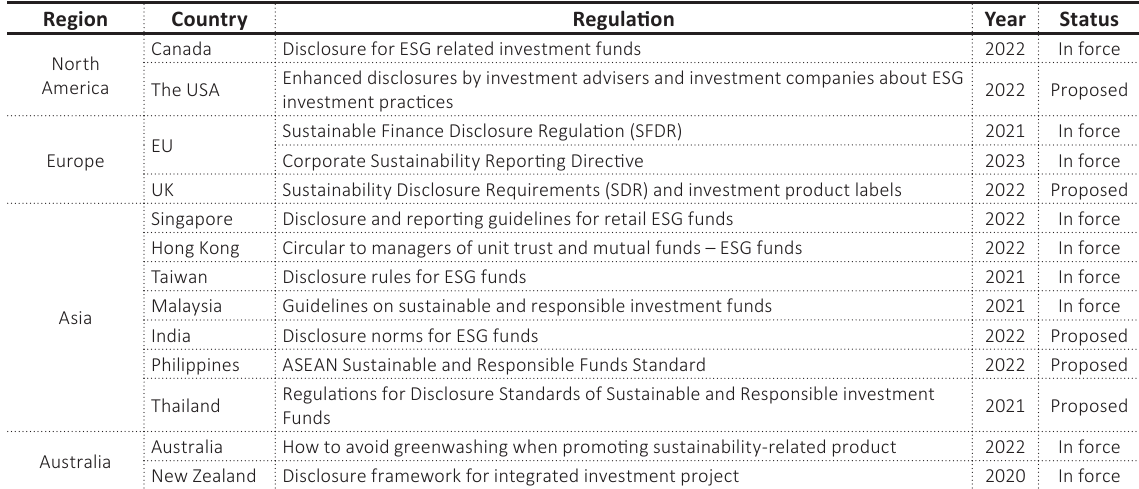
Source: Authors’ elaborations within MSCI (2022,